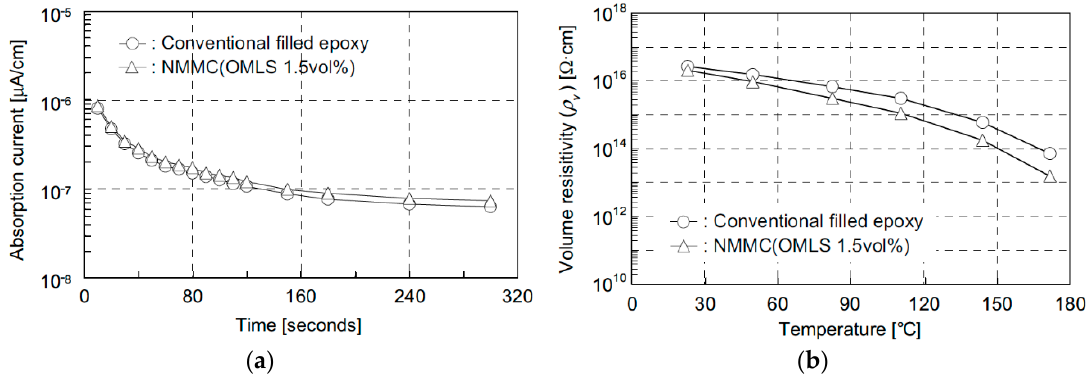
Figure 22. ( a ) Absorption currents in time after applying DC voltage (500 V) and ( b ) volume resistivity dependence with temperature (© 2016 IEEE. Reprinted, with permission, from [99]).